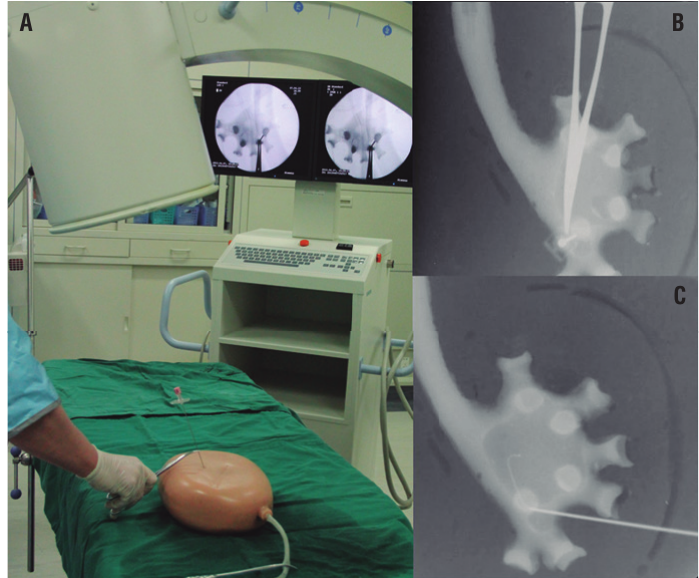
Figure 2 - a) Practice of fl uoroscopy guided PRA; b) Puncture, C-arm at 20 degrees; c) Guidewire placement, C-arm